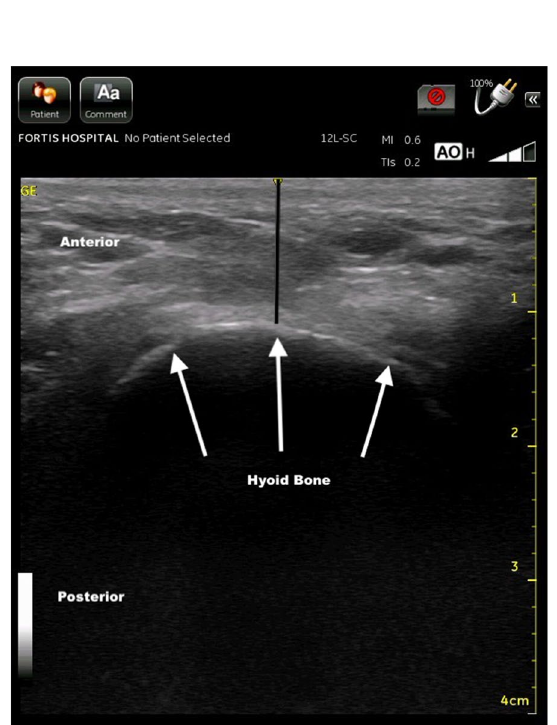
Fig. 1 Distance from anterior neck surface to hyoid bone (ANS-H). Legend: Black line indicating ANS-H distance